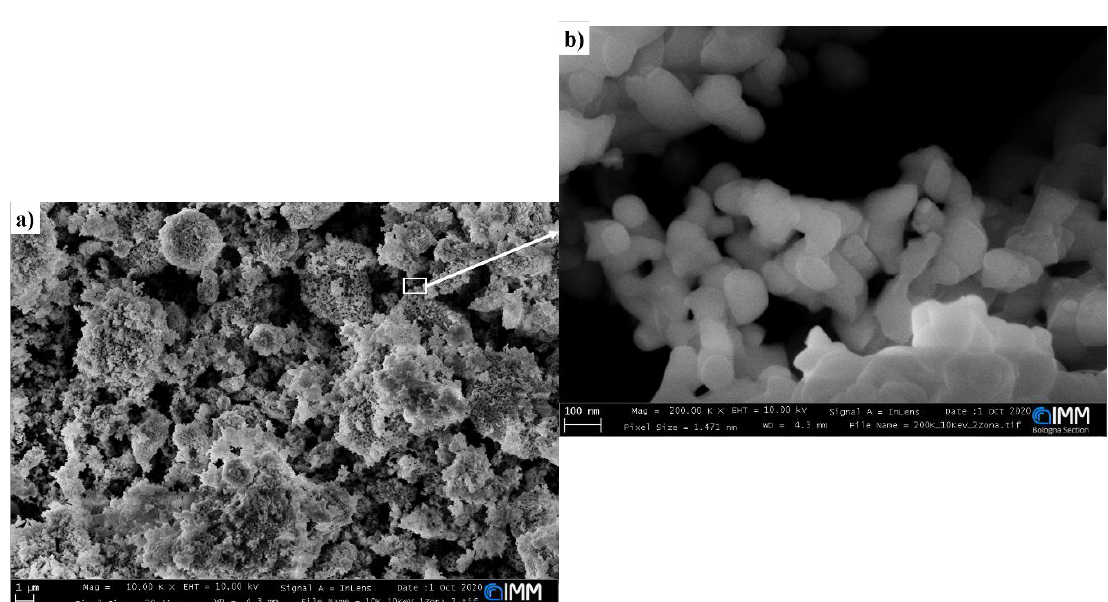
Figure 3. SEM images of the SmFeO 3 nanoparticles with magnifications of ( a ) 10 kx and ( b ) 200 kx.